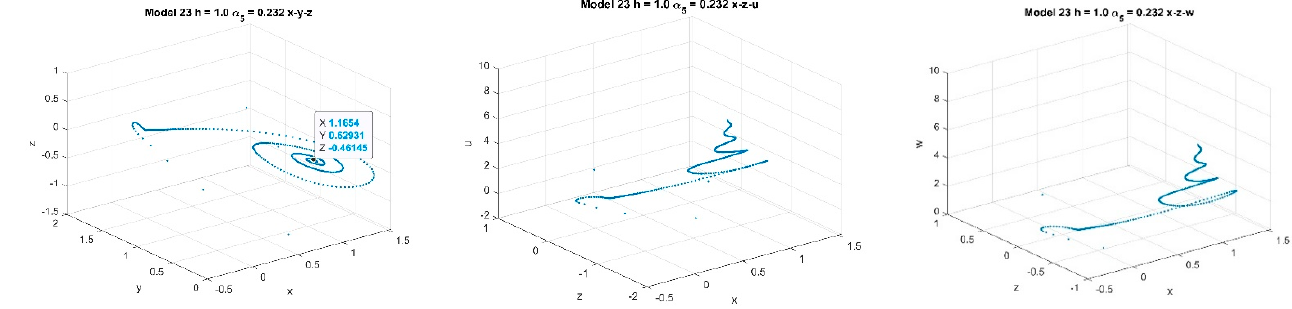
Figure 9. Phase portraits ( a ) x − y − z , ( b ) x − u − z , ( c ) x − z − w , at h = 0.1, k = 2, p = 1, α 5 = 0.232 for models (22) through (25).